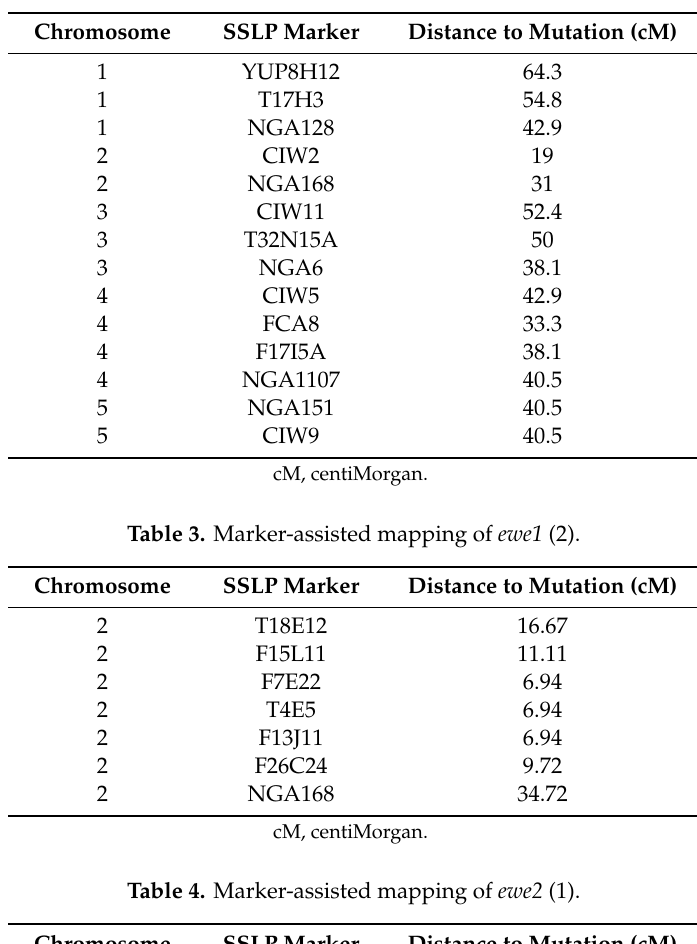
Table 2. Marker-assisted mapping of ewe1 (1).